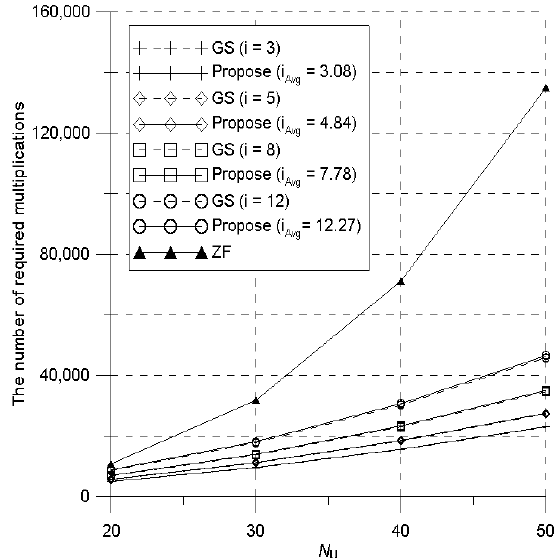
. In Figure 12, the values of